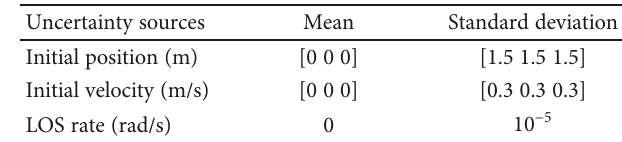
Table 3: Quanti fi cation of uncertainty